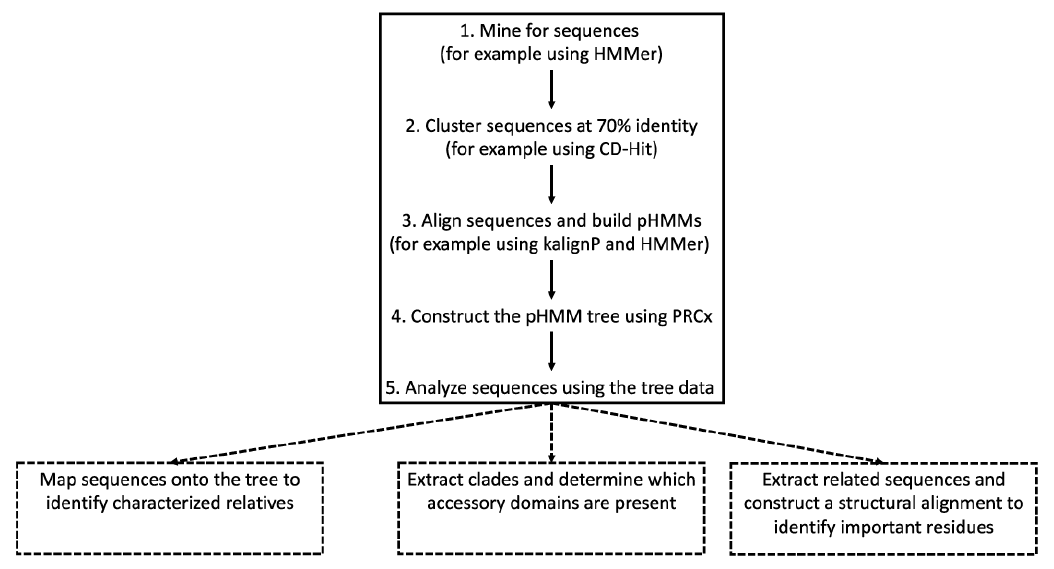
Figure 1. Flow chart indicating the steps in using PRCx. The steps are as follows. Create a sequence database, cluster sequences and construct alignments from them. Convert these alignments to pHMMs and construct the tree. The resulting tree can be used for example to identify relatives, extract sequences from a clade and mine determine their accessory domains or perform structural alignments to identify important